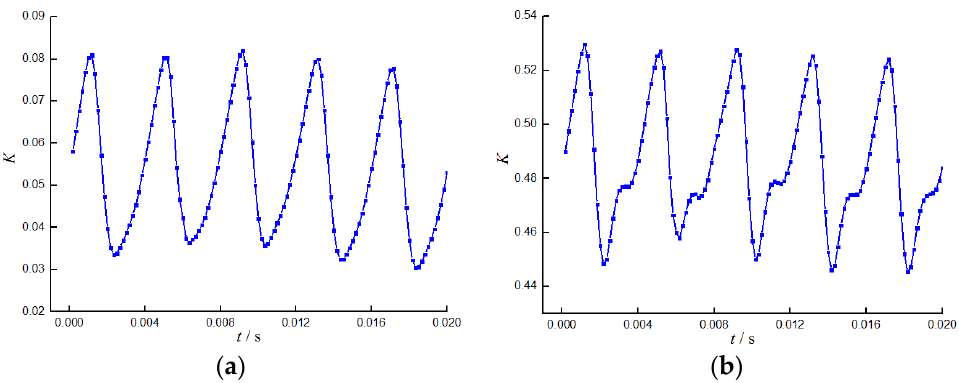
Figure 15. Time-domain results of radial hydraulic forces. ( a ) Pump impeller. ( b ) Pump volute.